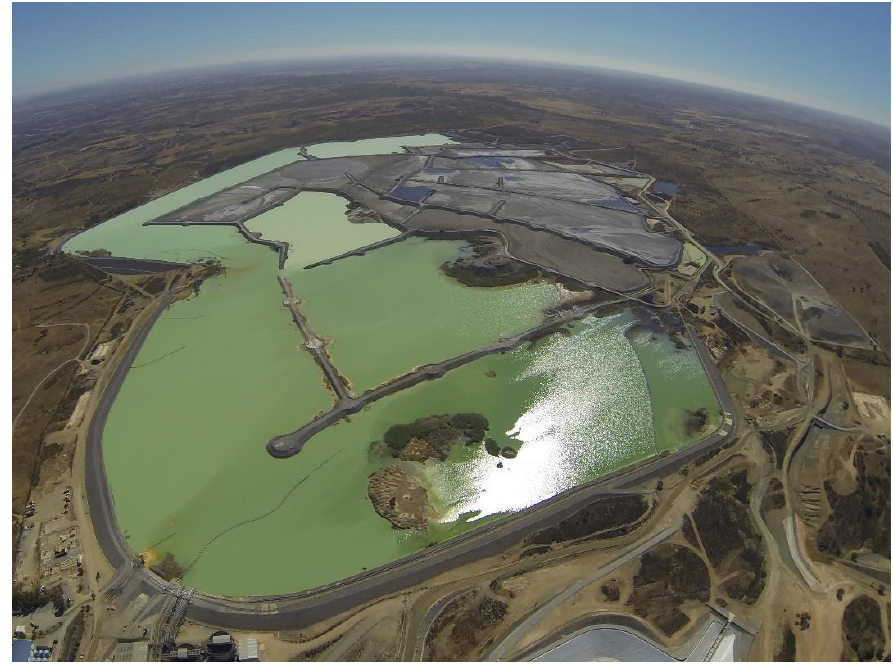
Figure 1. General view of the ponds.